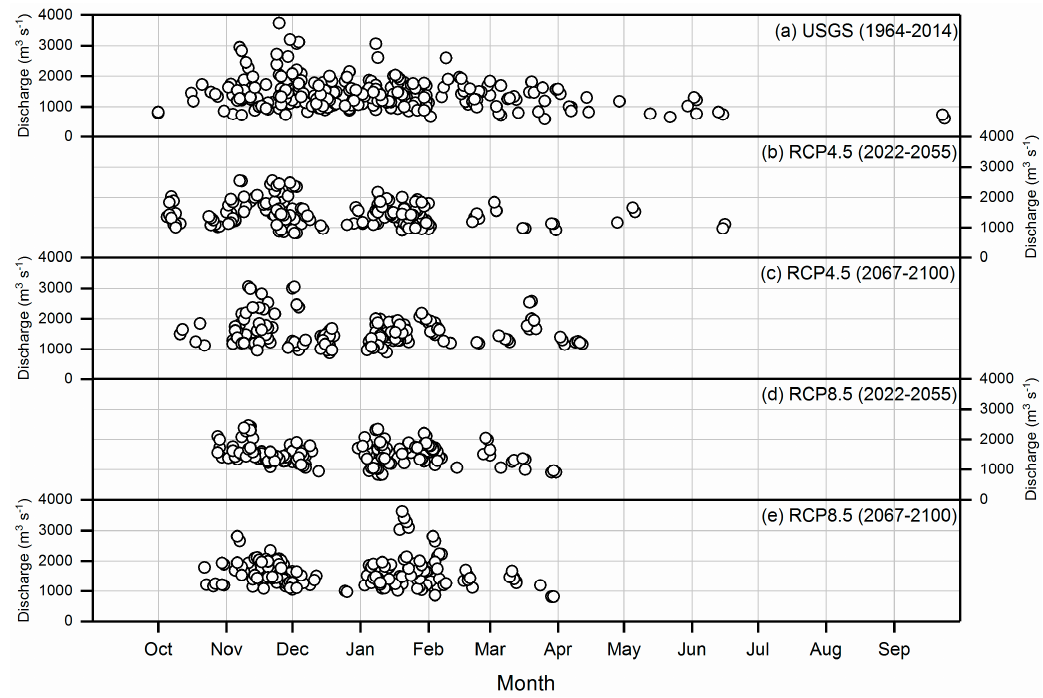
Figure 5. The timing of the five largest daily flows in each water year for different scenarios.